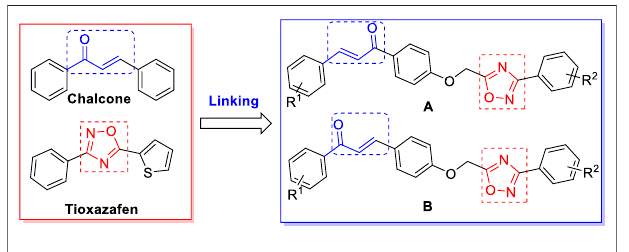
FIGURE 1 | Design of the target